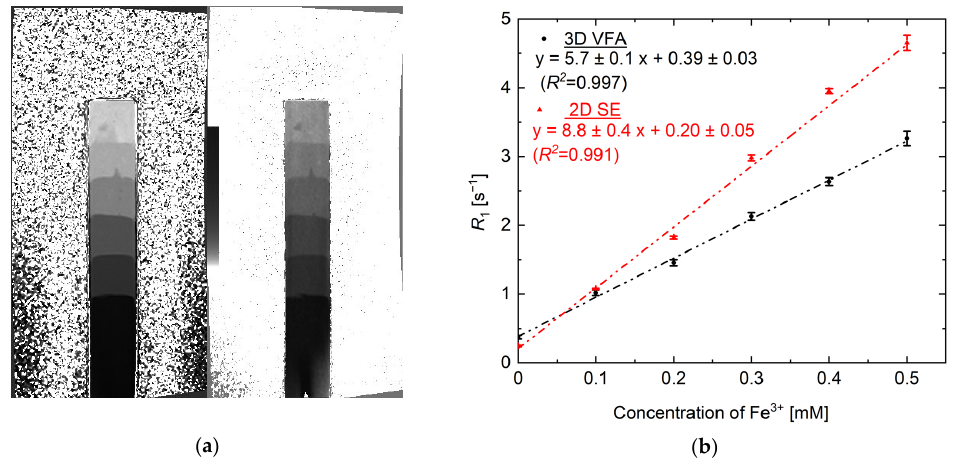
Figure 5. ( a ) R 1 maps of the reference gel obtained from the VFA (right) and SE methods (left). ( b ) Changes in the relaxation rate R 1 vs. (Fe 3+ ) used as the calibration curve. Squares and triangles represent the values obtained from the VFA and SE methods, respectively. The error bars are the standard deviation (SD) in the circular region of interest (ROI) φ 10 mm. The dashed line represents a linear fit to the data.